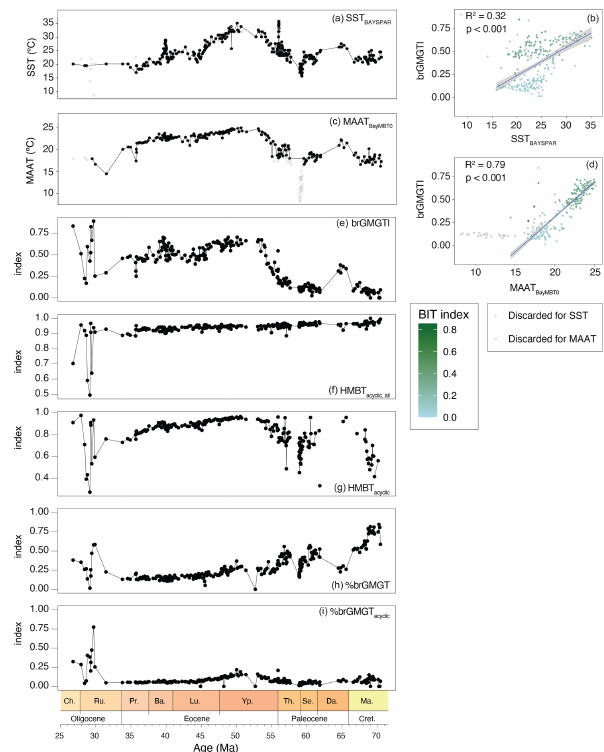
Figure 12. Time series and cross plots of brGMGT-based in- dices with MAAT and SST reconstructions. (a) SST lin (b) cross plot of SST lin and brGMGTI, (c) MAAT soil , (d) cross plot of MAAT soil and brGMGTI, (e) brGMGTI, (f) HMBT acyclic , all , (g) HMBT acyclic , (h) %brGMGT (Baxter et al., 2019), (i) %brGMGT acyclic (Naafs et al., 2018a). For equations, see Table 1). Variable colors in the cross plots indicate the BIT index